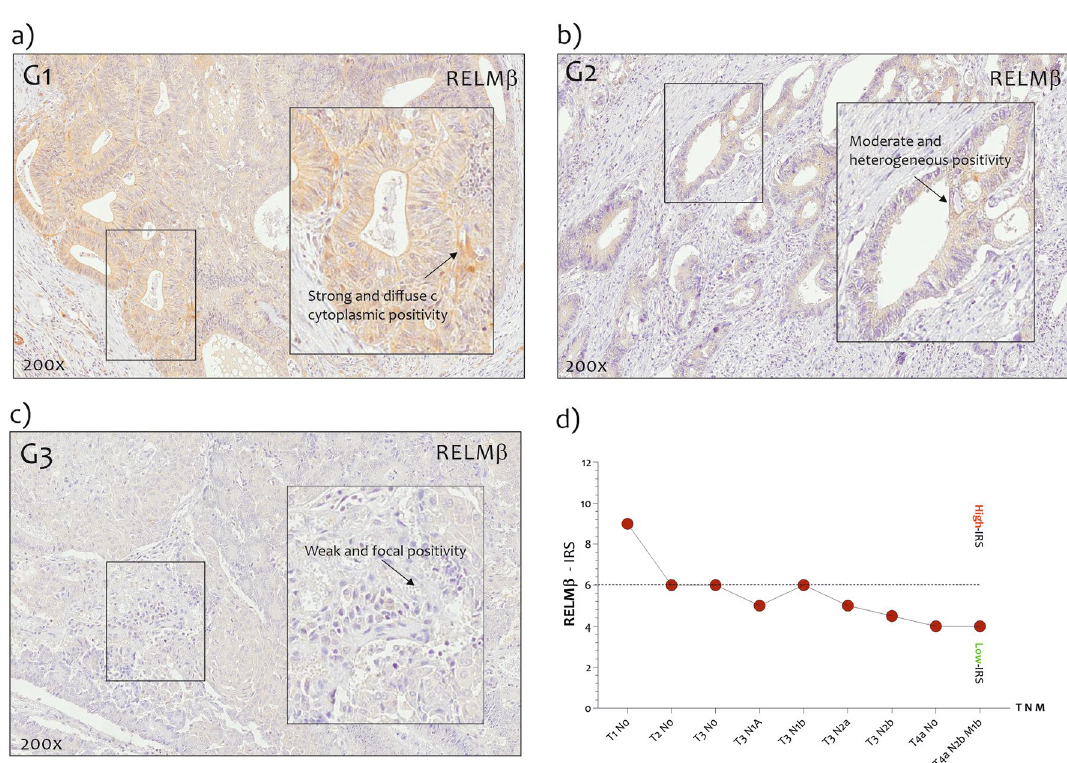
Figure 7. RETNLB protein detection in CRC biopsies from G1, G2, and G3 grade. ( a ) Immunostaining of RETNLB (RELMβ) in G1 CRC biopsies; ( b ) in G2 CRC biopsies ( c ), and G3 CRC biopsies. The boxes represent magnification of the original figure. The black arrows indicate the location. ( d ) Immunoreactivity Score (IRS) was obtained by multiplying IS and ES and it was considered as low (L-IRS), if < 6, and as high (H-IRS), if ≥ 6,